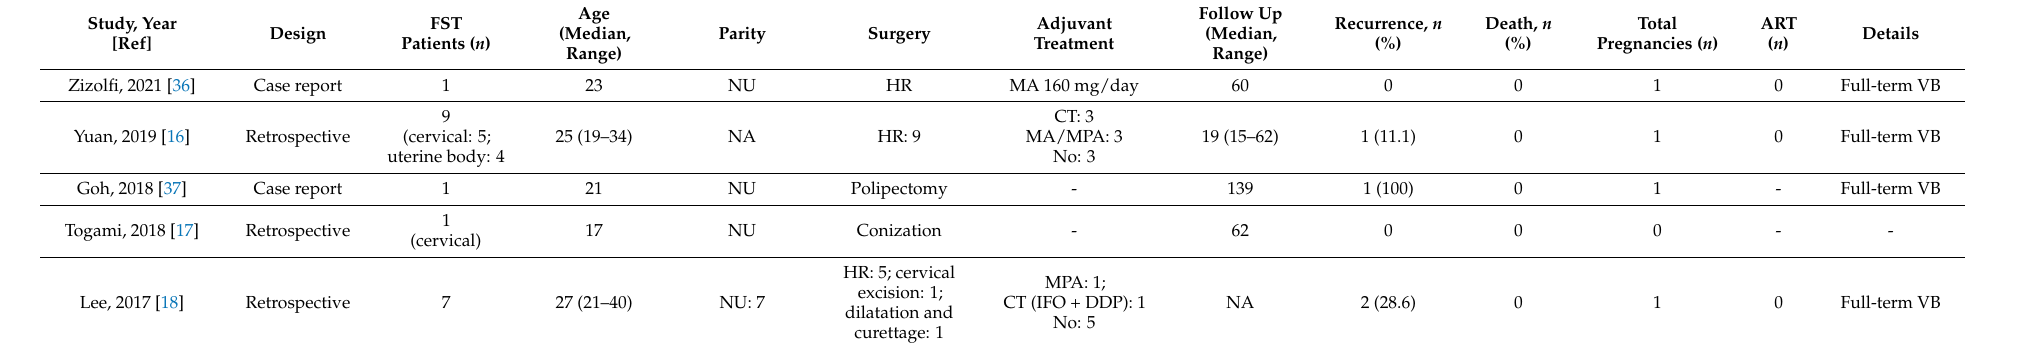
Table 4. Published reproductive and oncologic outcomes after FST of